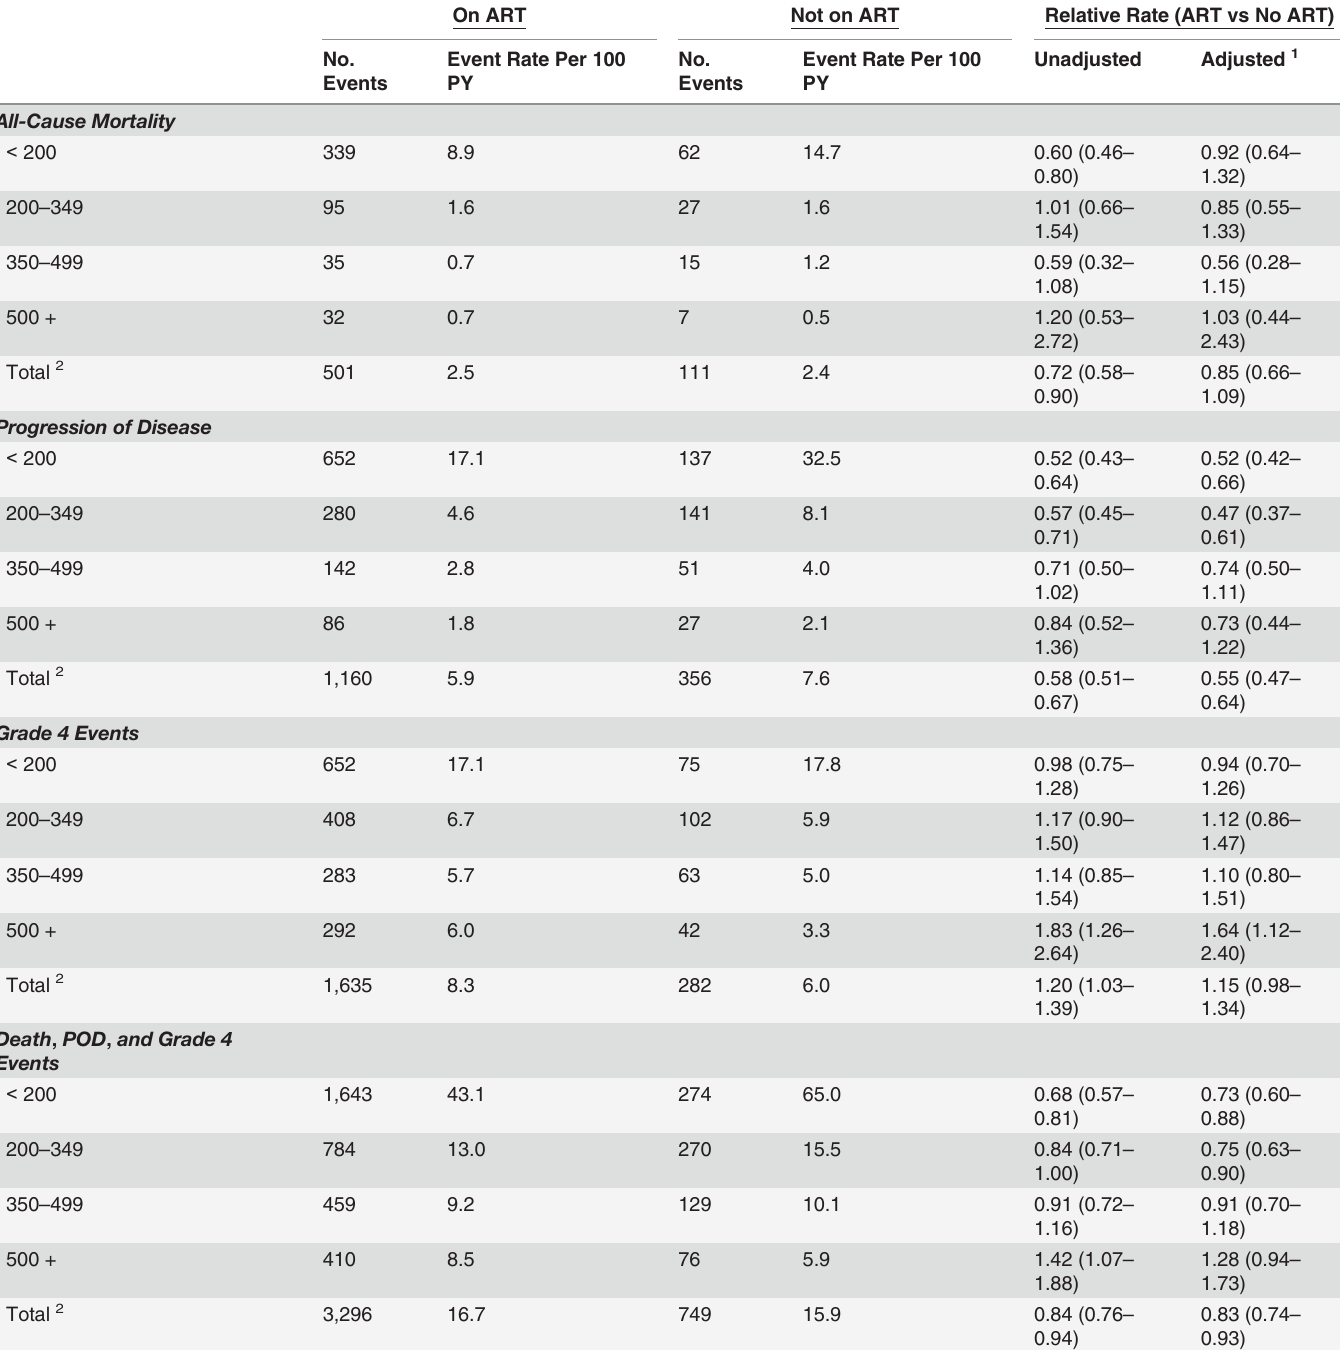
Table 5. Morbidity and Mortality Rates by Latest CD4 Count and ART Status and Relative Rates (ART vs No ART) by CD4 Count (cells/mm 3 ): Mor- bidity and Mortality